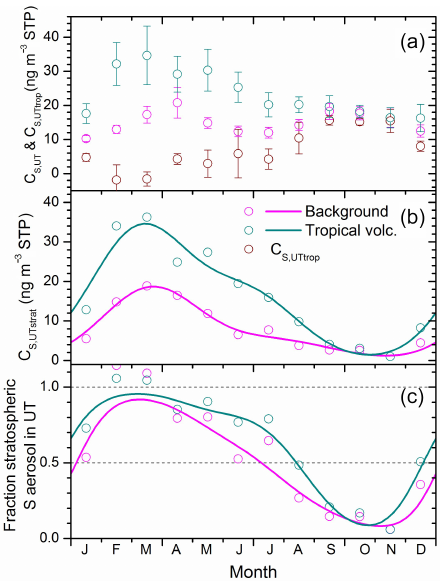
Figure 7. Seasonal variation of (a) the UT particulate sulfur concen- tration during LMS background conditions and moderate volcanic influence, together with the estimated UT particulate sulfur concen- tration of tropospheric origin ( C S , UTtrop ) , (b) UT particulate sulfur concentration of stratospheric origin ( C S , UTstrat ) obtained by sub- tracting the C S , UTtrop from the two UT concentration cases in (a) and the ratio C S , UTstrat /C S , UT for the two cases (c) .